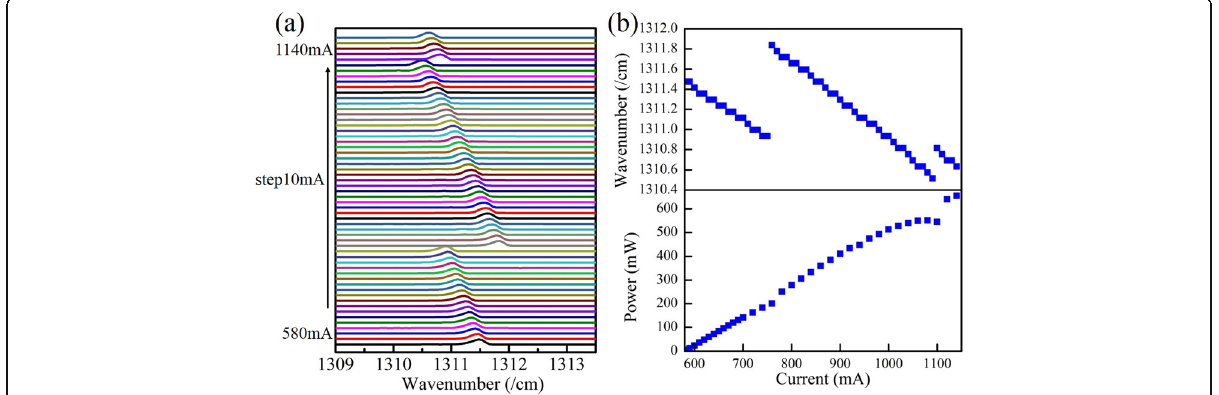
Fig. 5 a The emission spectrum changing with the injection current. b The top panel shows the wavenumber versus temperature curve, and the bottom panel is the CW power – current (P – I) curve of laser